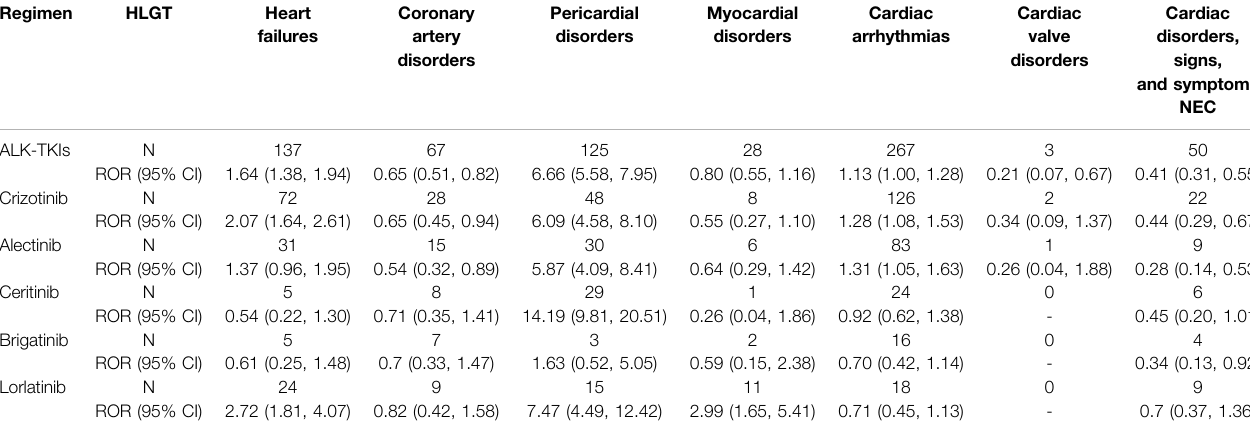
a CI: con fi dence interval; N: the number of cases, ROR: reporting odds ratio.